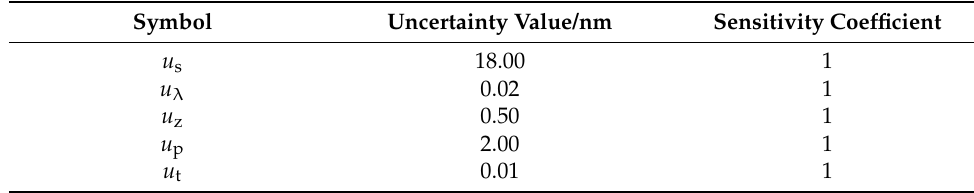
Table 1. Summary of the standard uncertainty components of step